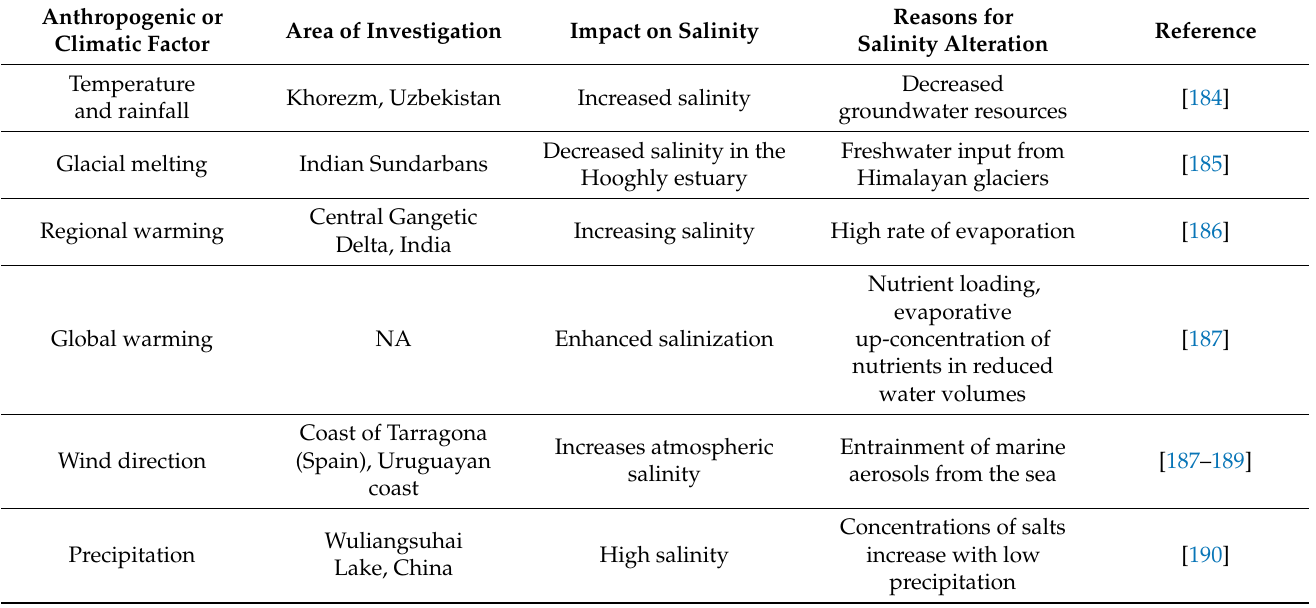
Table 4. Effects of anthropogenic factors on changes in salinity in coastal